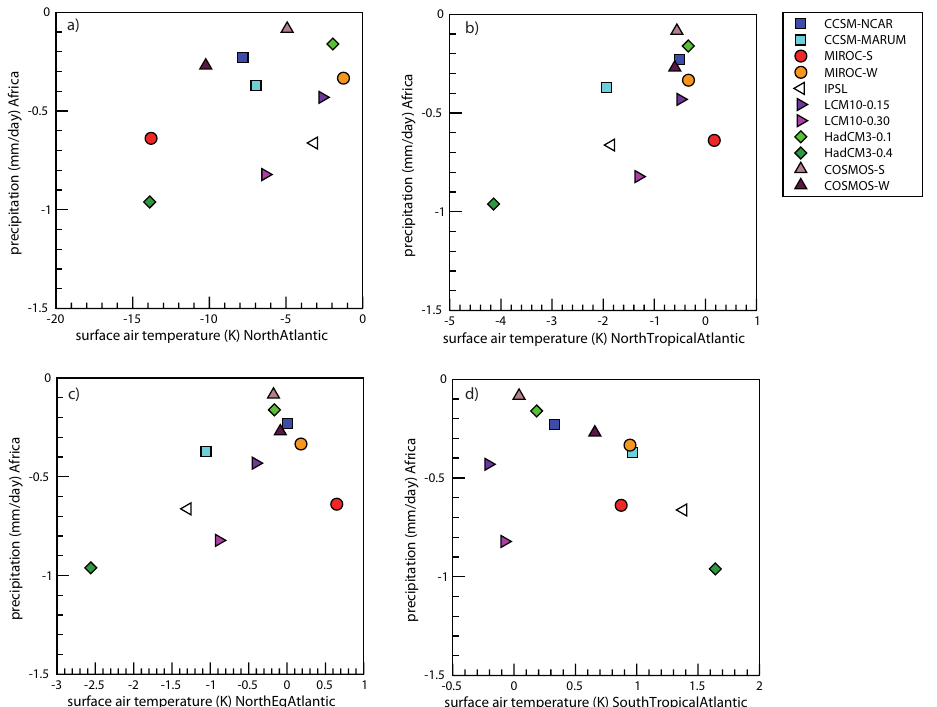
Fig. 9. Relationships involving precipitation changes over the African monsoon region, defined for latitudes between 5 and 15 ◦ N and longi- tudes between 15 ◦ W and 15 ◦ E; (a) with NorthAtlantic temperatures, (b) with NorthTropicalAtlantic temperatures, (c) with NorthEqAtlantic temperatures and (d) with SouthTropicalAtlantic